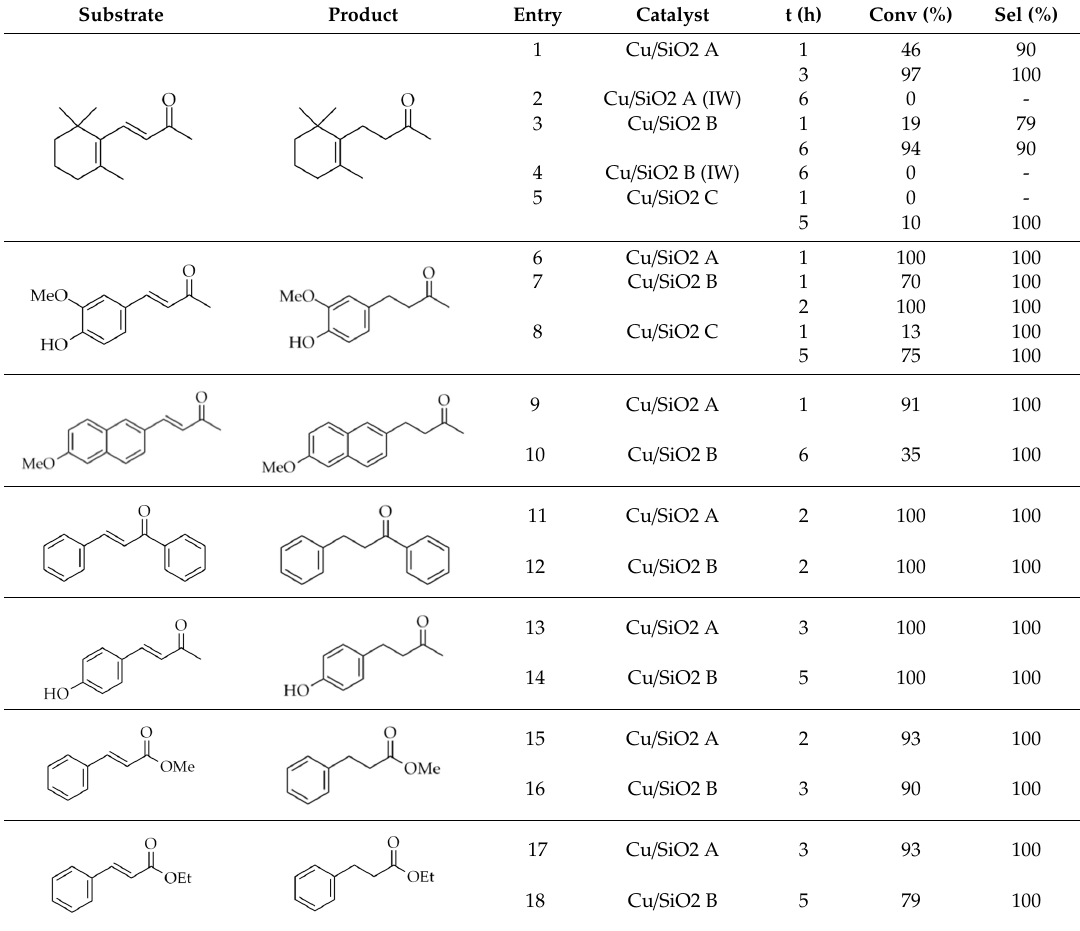
Table 2. Selective reduction of different α , β -unsaturated compounds with silica-supported copper catalysts at 90 °C and 1 Bar of H 2 .